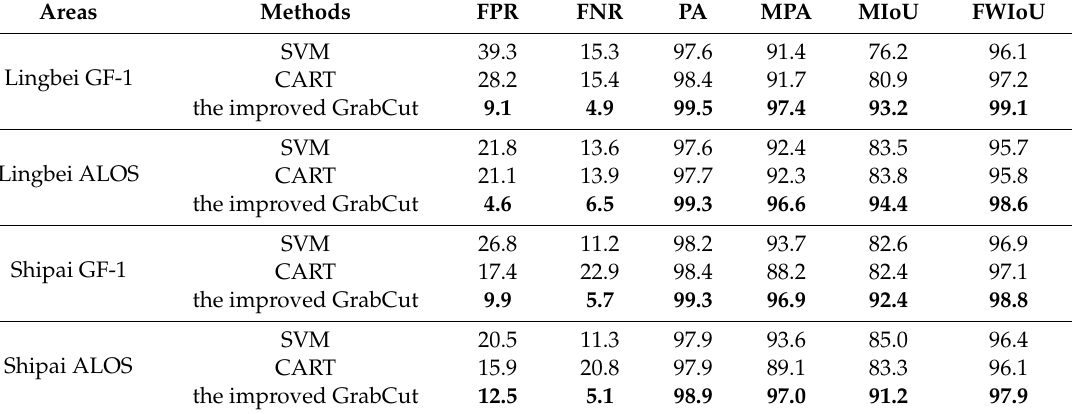
Table 5. Accuracy of REO mining area extraction with di ff erent